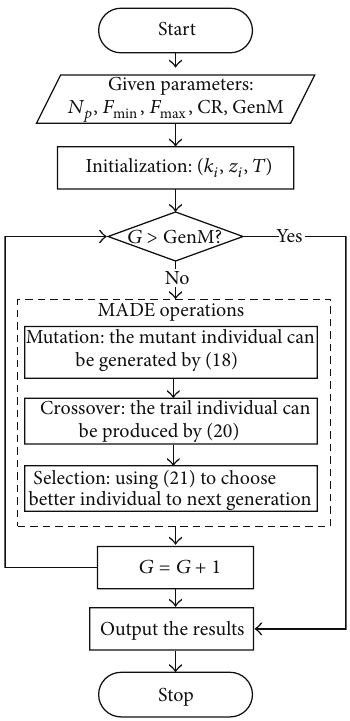
Figure 1: Flow chart of the